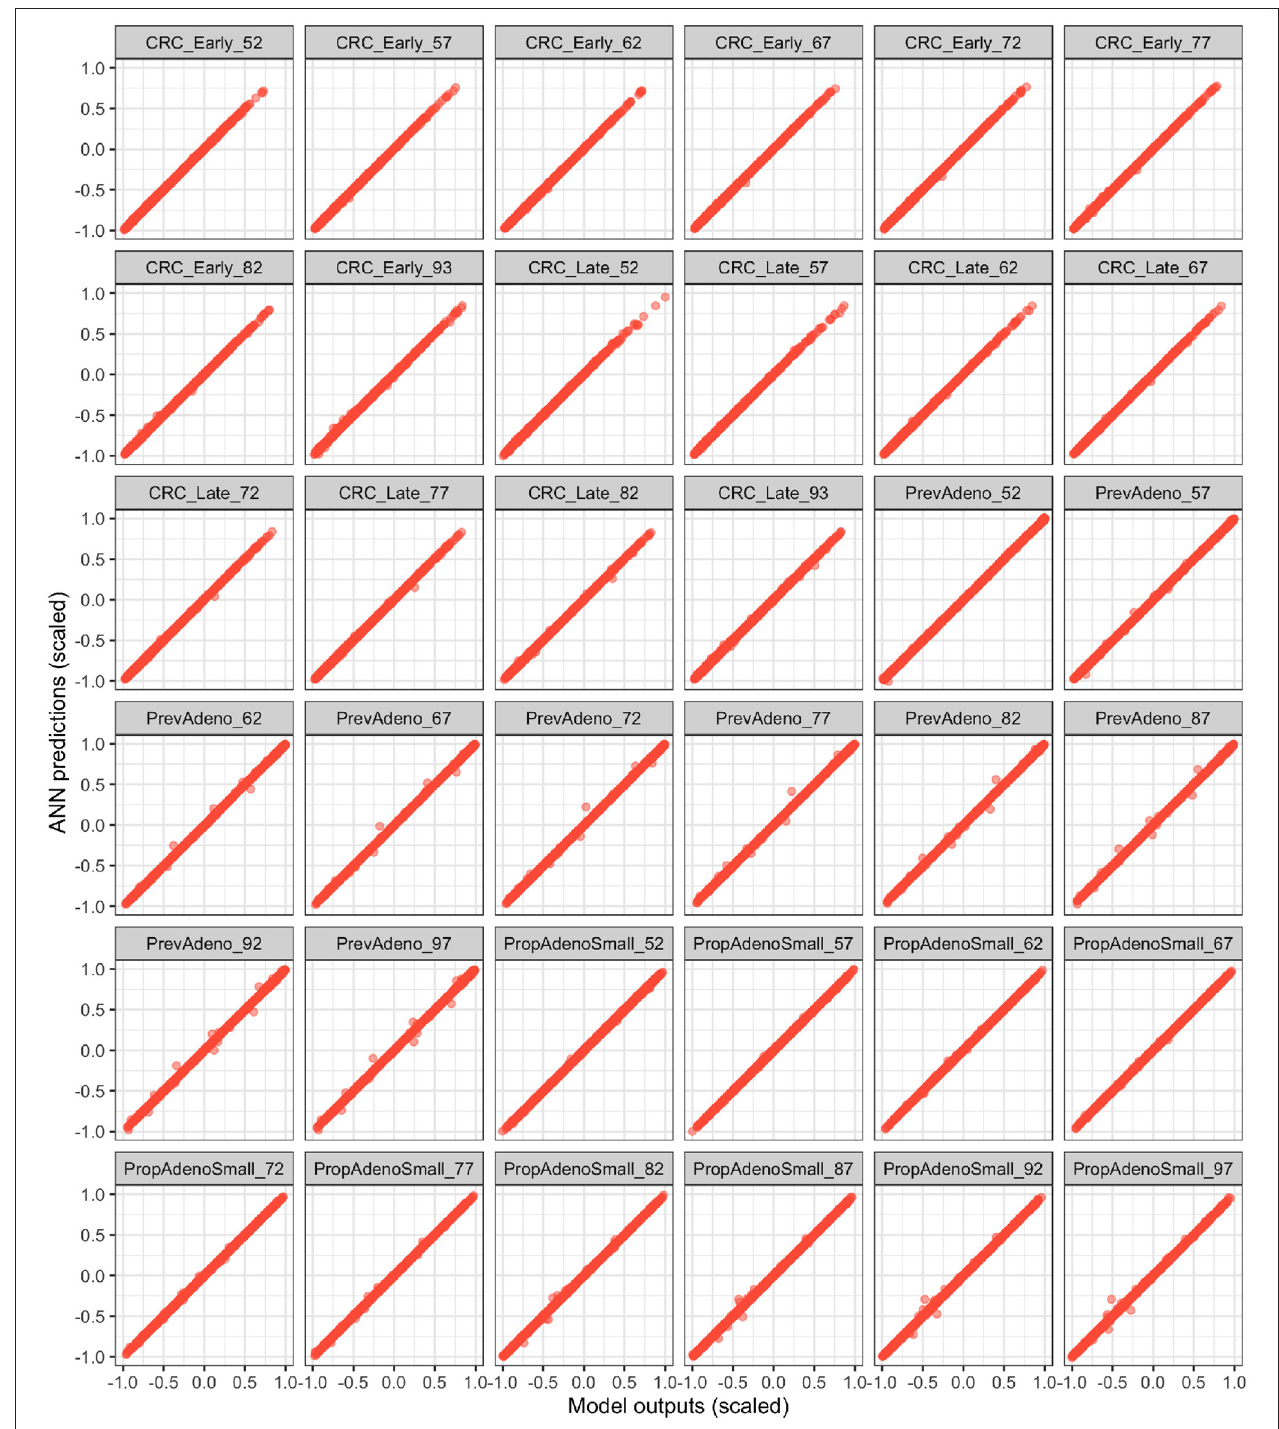
FIGURE 4 | Validation of the fitted ANN on the validation Latin hyper cube sample (LHS) dataset. The x and y axes represent the scaled model outputs and scaled ANN predictions, respectively.